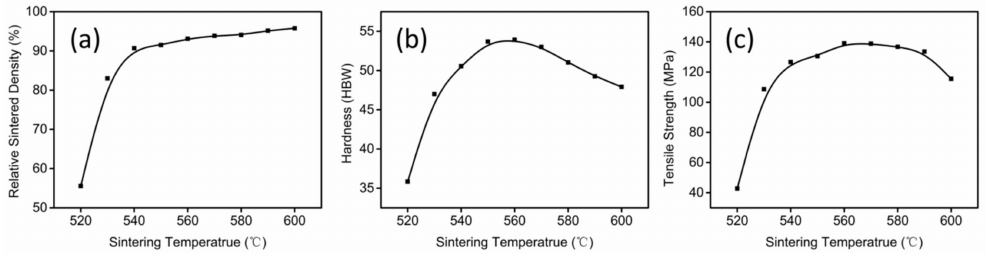
Figure 6. ( a ) Relative sintered density; ( b ) hardness; and ( c ) tensile strength of parts sintered at different sintering temperatures for 1 h.